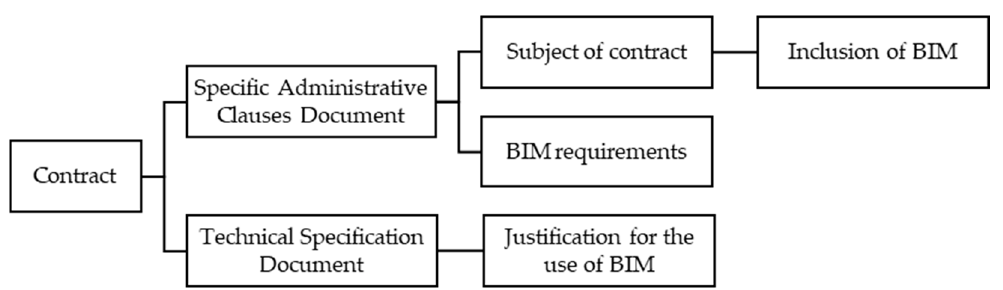
Figure 3. BIM inclusion in Spanish public procurement.